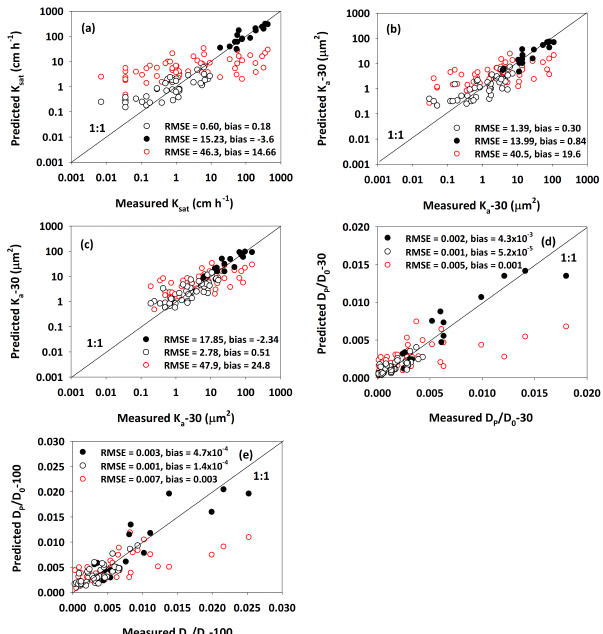
Figure 9. Predictive performance of the Ahuja et al. (1984) model parameterized with air-filled porosity at − 30kPa (red empty symbols), X-ray CT-derived effective percolating macroporosity (EPMP) (black filled symbols), and total macroporosity (MP) (black empty symbols), respectively. Predicted (a) saturated hy- draulic conductivity, (b) air permeability at − 30cm matric poten- tial, (c) air permeability at − 100cm matric potential, (d) gas diffu- sivity at − 30cm matric potential, and (e) gas diffusivity at − 100cm matric